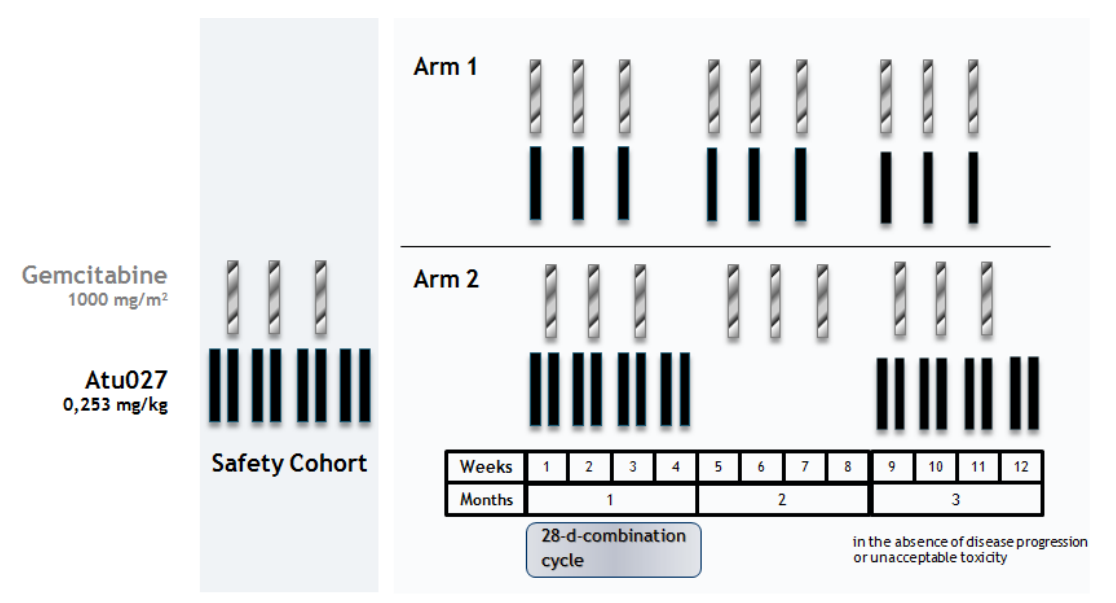
Figure 2. Assessment cycle in Arms 1 and 2.